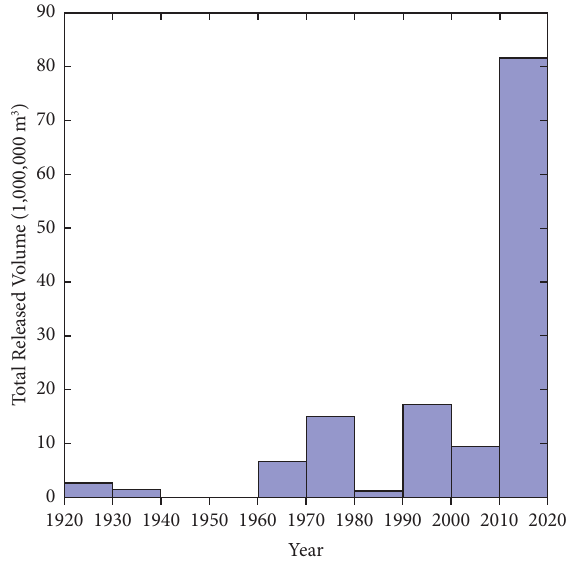
Figure 15: Released volume as a function of total volume of tailings stored (data from Rana et al. [72]).